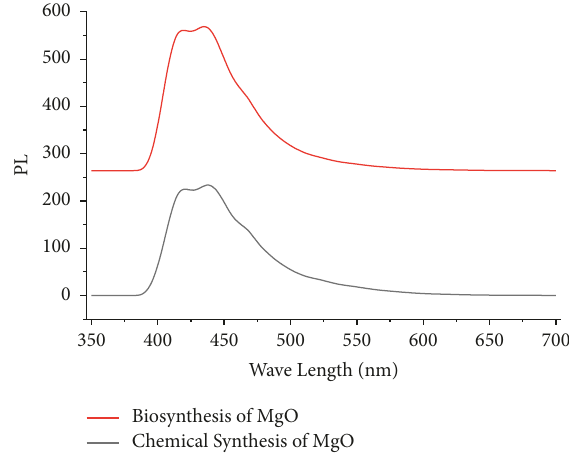
Figure 6: Photoluminescence (PL) spectrum of biosynthesized and chemosynthesized magnesium oxide (MgO) nanoparticles derived from Datura stramonium leaves